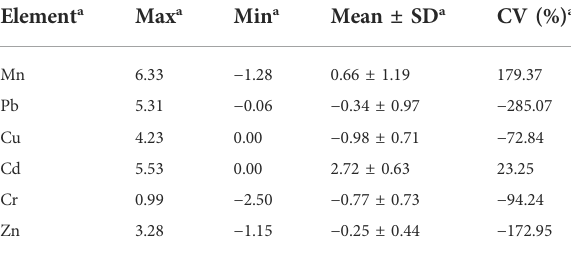
TABLE 4 Geoaccumulation index (Igeo) statistics of six heavy metals on Mn contaminated